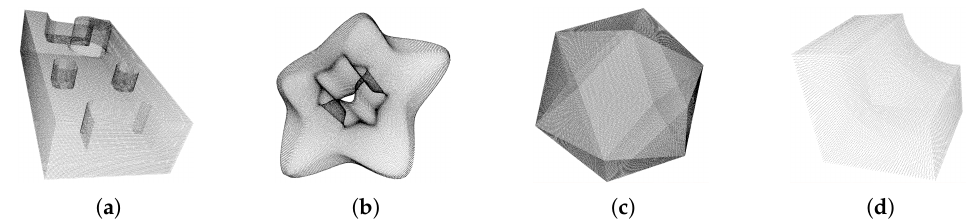
Figure 8. Set of testing models for comparison ( a ) similar to model in [18], ( b – d ) similar to models in